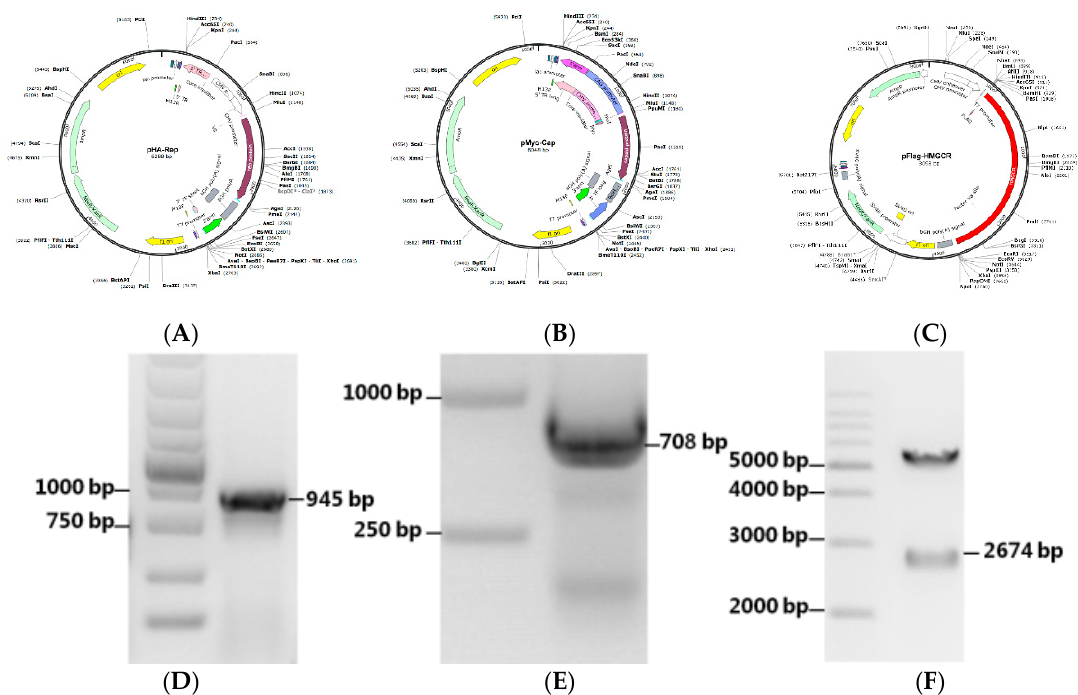
Figure 5. Construction scheme of the plasmids used in this study. The Cap and Rep genes of PCV2 were cloned into Lenti-CAG-WPRE by Mlu I and Age I to generate recombinant expression plasmids pHA-Rep ( A , D ) and pMyc-Cap ( B , E ), respectively and were further verified by PCR. The porcine HMGCR gene was cloned into pCDNA3.1( + ) by Bam H I and Eco R I to generate the expression plasmid pFlag-HMGCR ( C ) and confirmed by double digestion with Bam H I and Eco R I ( F